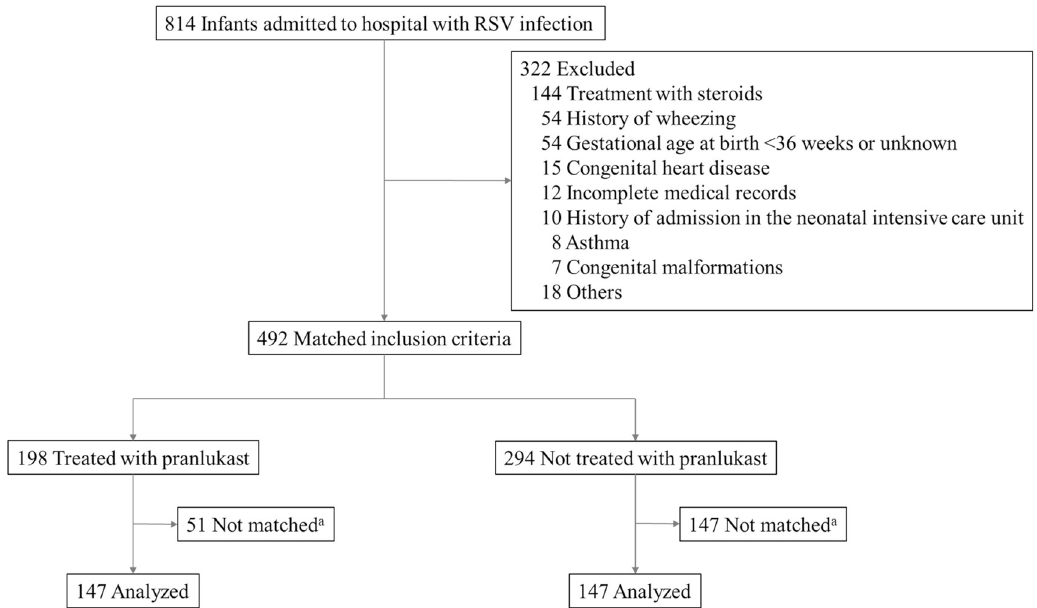
Fig 1. Study flow chart. a Infants treated with pranlukast were propensity score-matched with infants not treated with pranlukast in a 1:1 ratio using nearest-neighbor matching.